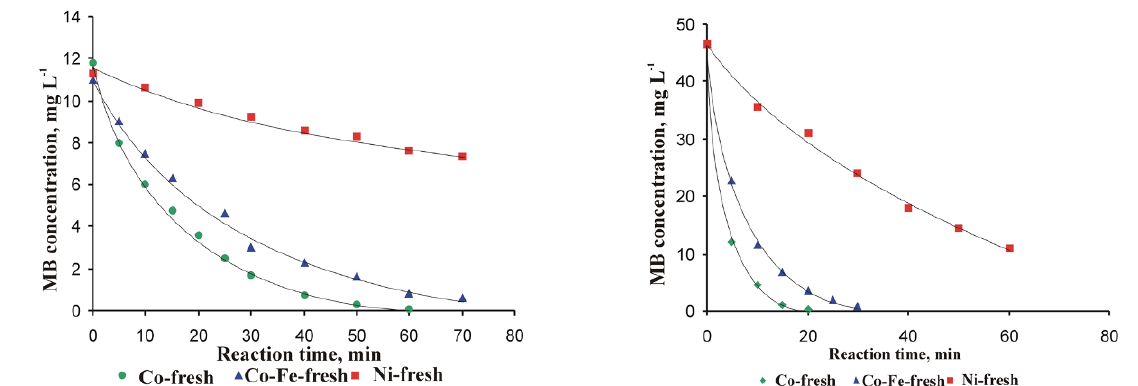
Figure 5. Kinetics curves of MB oxidation for different initial concentration.